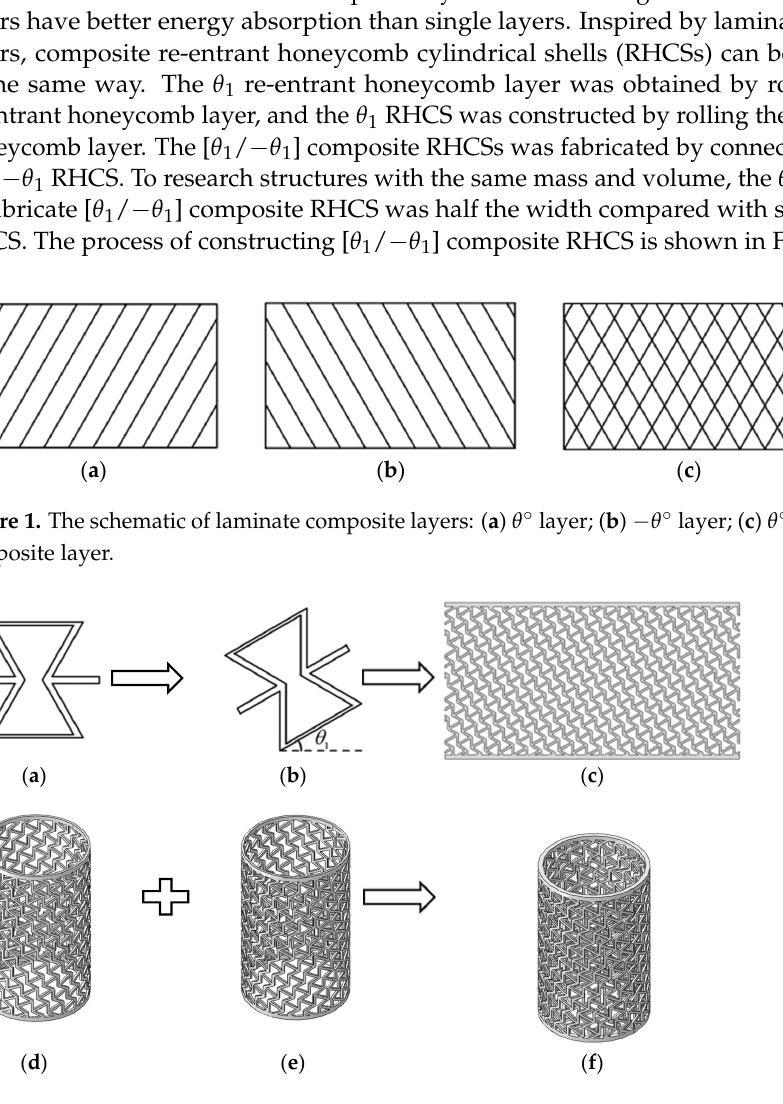
Figure 3. The joints of θ 1 RHCSs. Figure 4. Geometrical configuration of a re-entrant honeycomb cell.